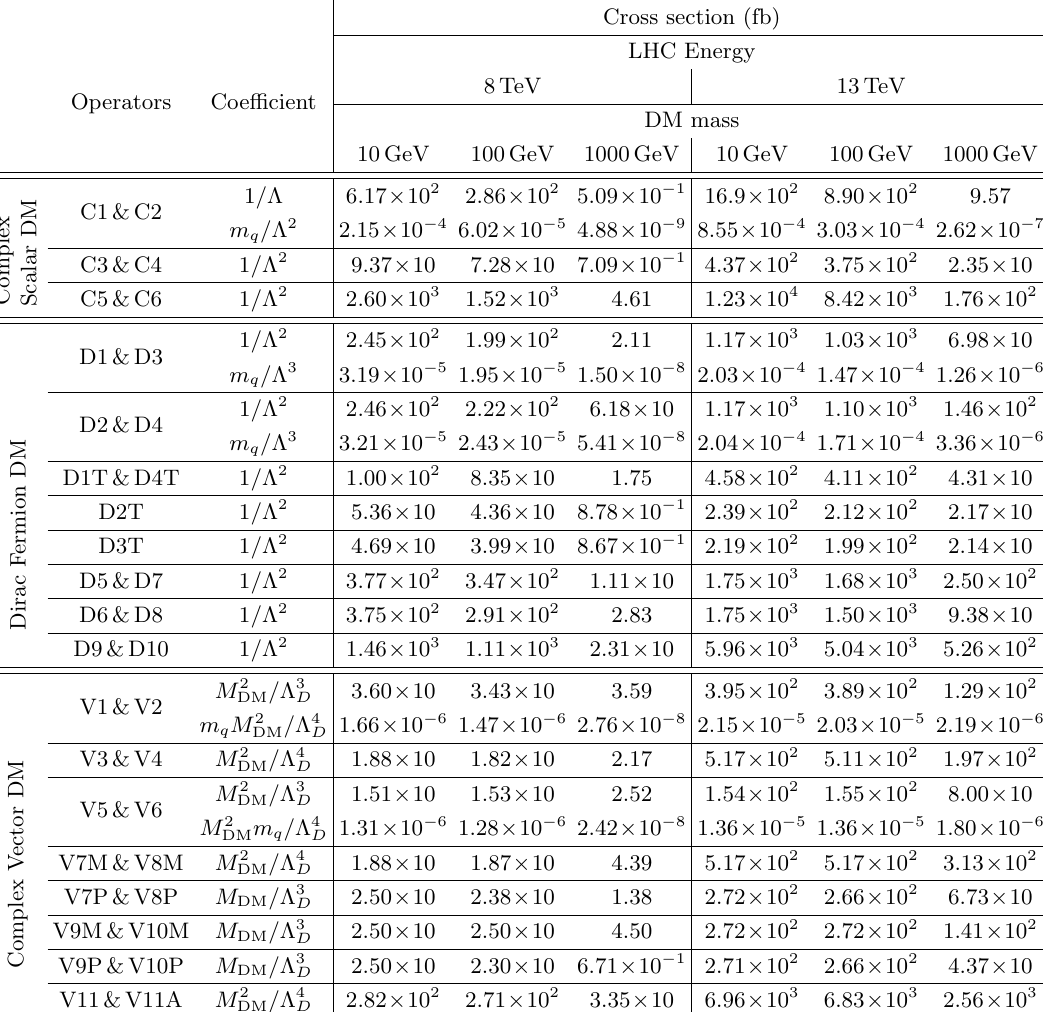
Table 4 . Mono-jet cross-sections in fb for the EFT operators at 8 TeV and 13 TeV. The UV cut-o(cid:11) (cid:3) has been set to 1 TeV for all operators. Operators with same cross-section have been grouped